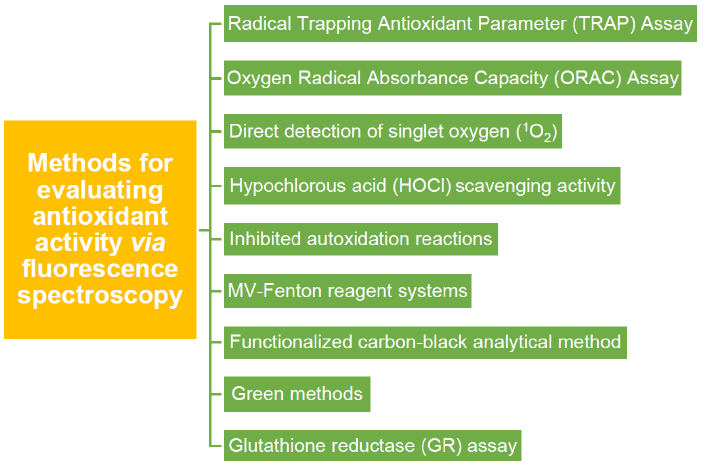
Figure 10. Multiple methodologies are referred to in the literature for evaluating antioxidant activity using fluorescence spectroscopy.